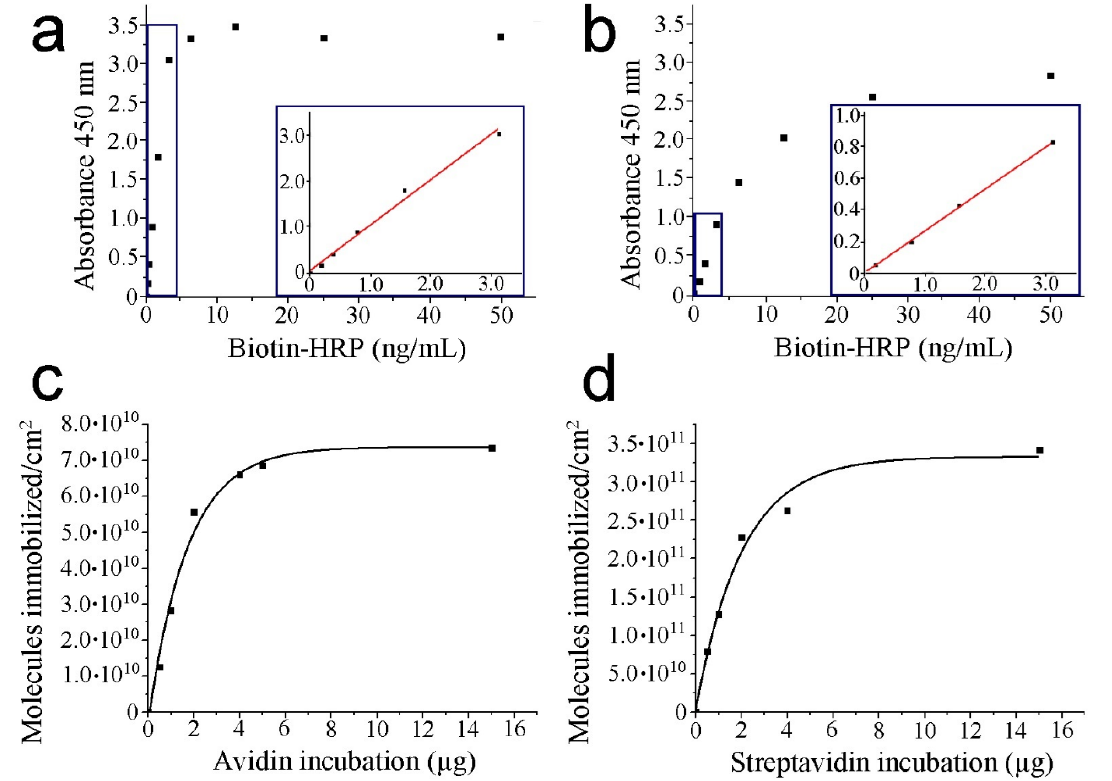
Figure 2. HRP–biotin enzymatic assays. The absorbance is due to the oxidation of TMB under the presence of H 2 O 2 in PBS-EDTA buffer after incubation for 5 min. Sulfuric acid was added to stop the reaction. Calibration curves of avidin ( a ) and streptavidin ( b ), respectively. The inset figures (blue squares) depict a zoom of the curve region considered to perform the linear fitting. Representation of the attached molecules per area unit respect protein incubation for avidin ( c ) and streptavidin ( d ), respectively.